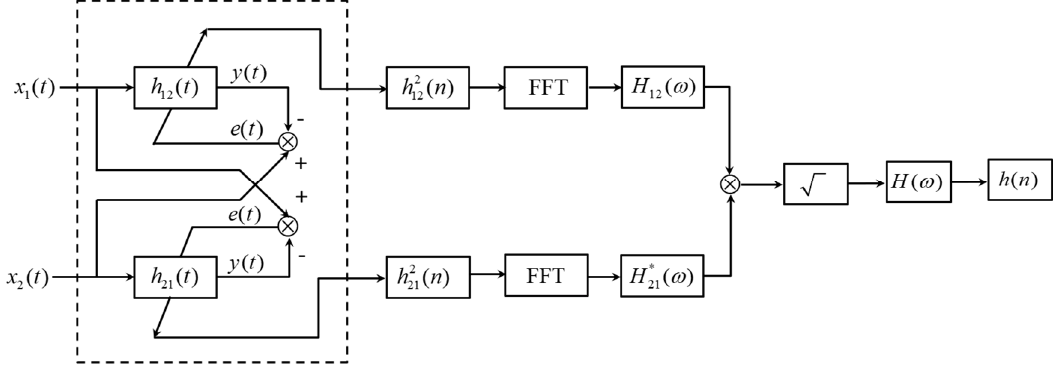
Figure 3. Implementation of the ADPHAT method.